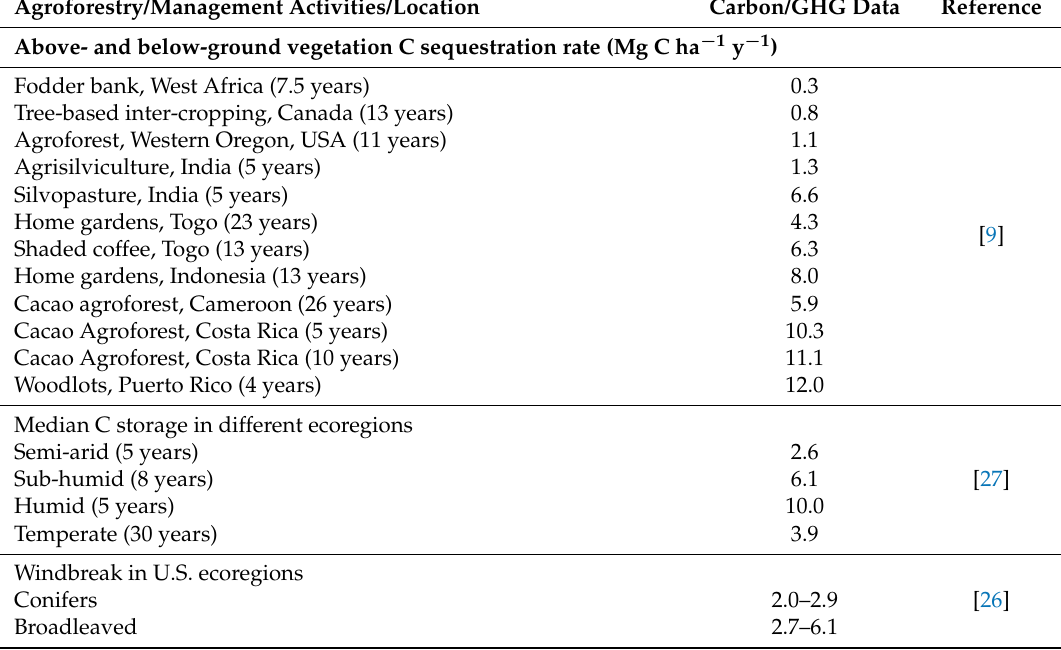
Table 1. Carbon sequestration rate, carbon stocks and greenhouse gas (GHG) emissions in different types of agroforestry systems. A negative flux shows consumption of